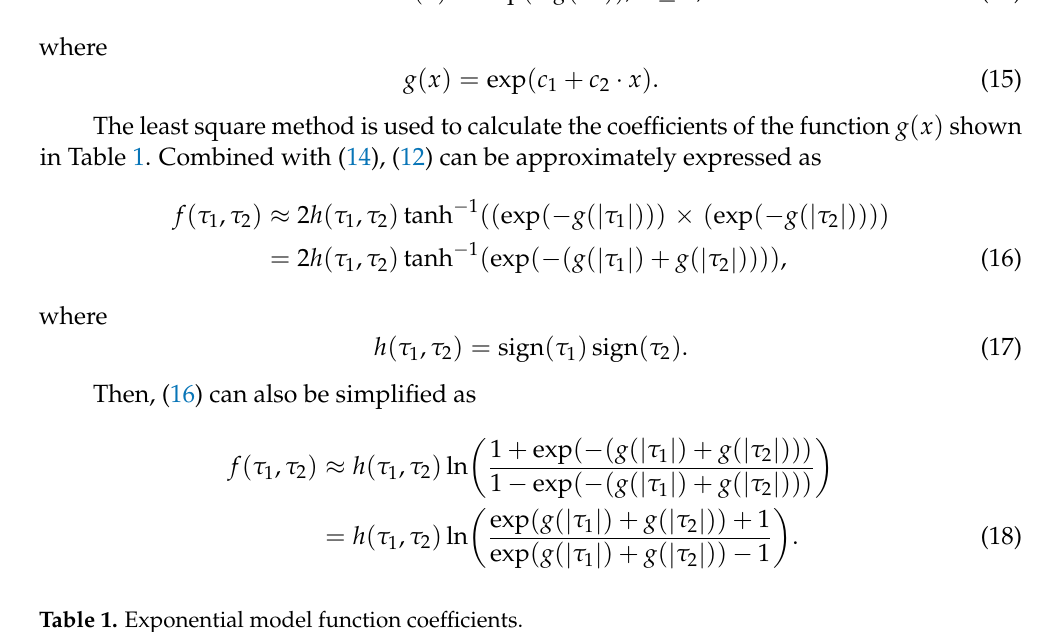
Table 1. Exponential model function